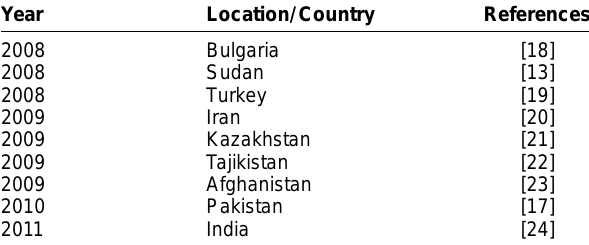
of livestock or were the doctors treating the infected segment encodes for viral polymerase. (self-designed figure) cases.